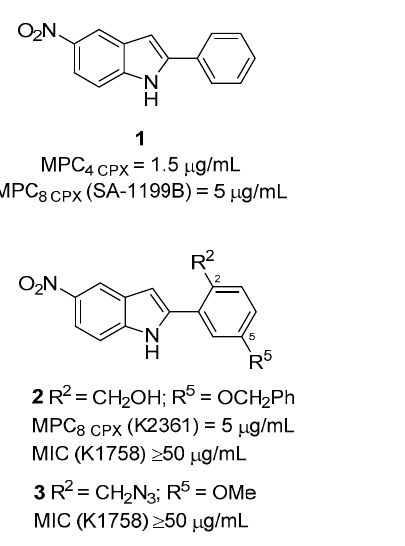
Figure 2. From indoles to benzothiophene and benzofuran